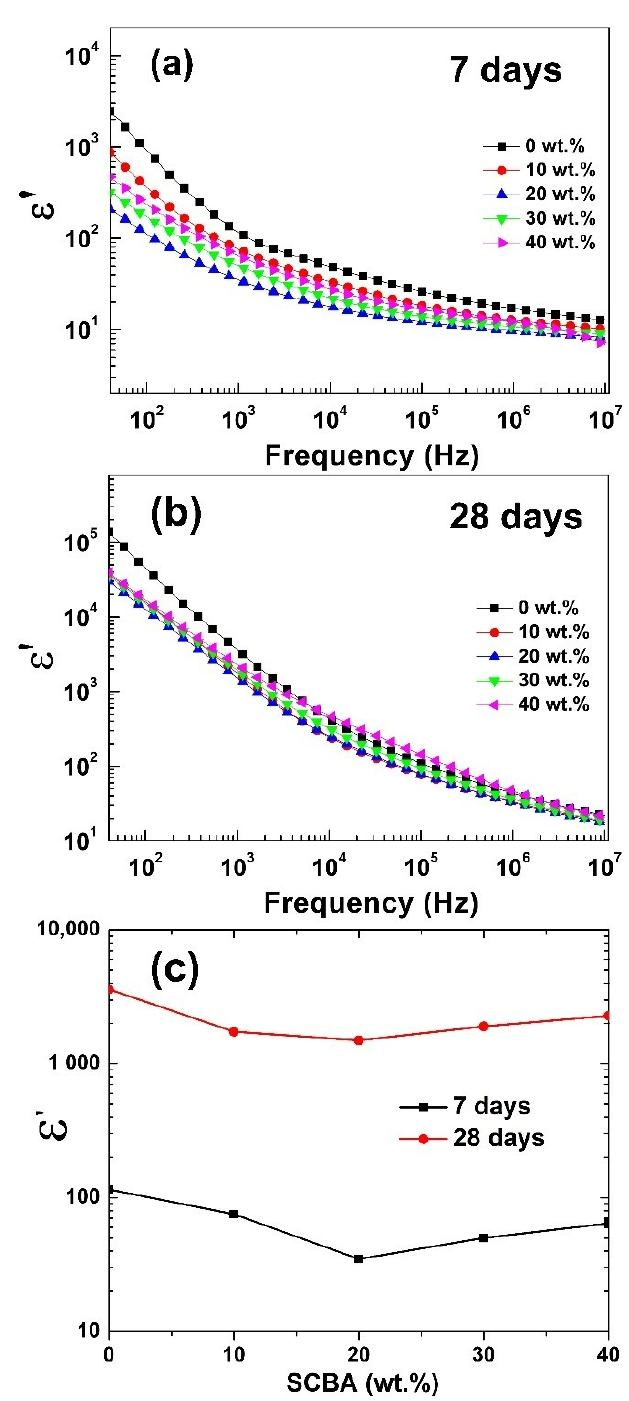
Figure 8. The dielectric constant ε′ of geopolymer/SCBA pastes at ( a ) 7 days and ( b ) 28 days. ( c ) The variation of ε′ at 1 kHz as a function of SCBA wt.% in geopolymer.